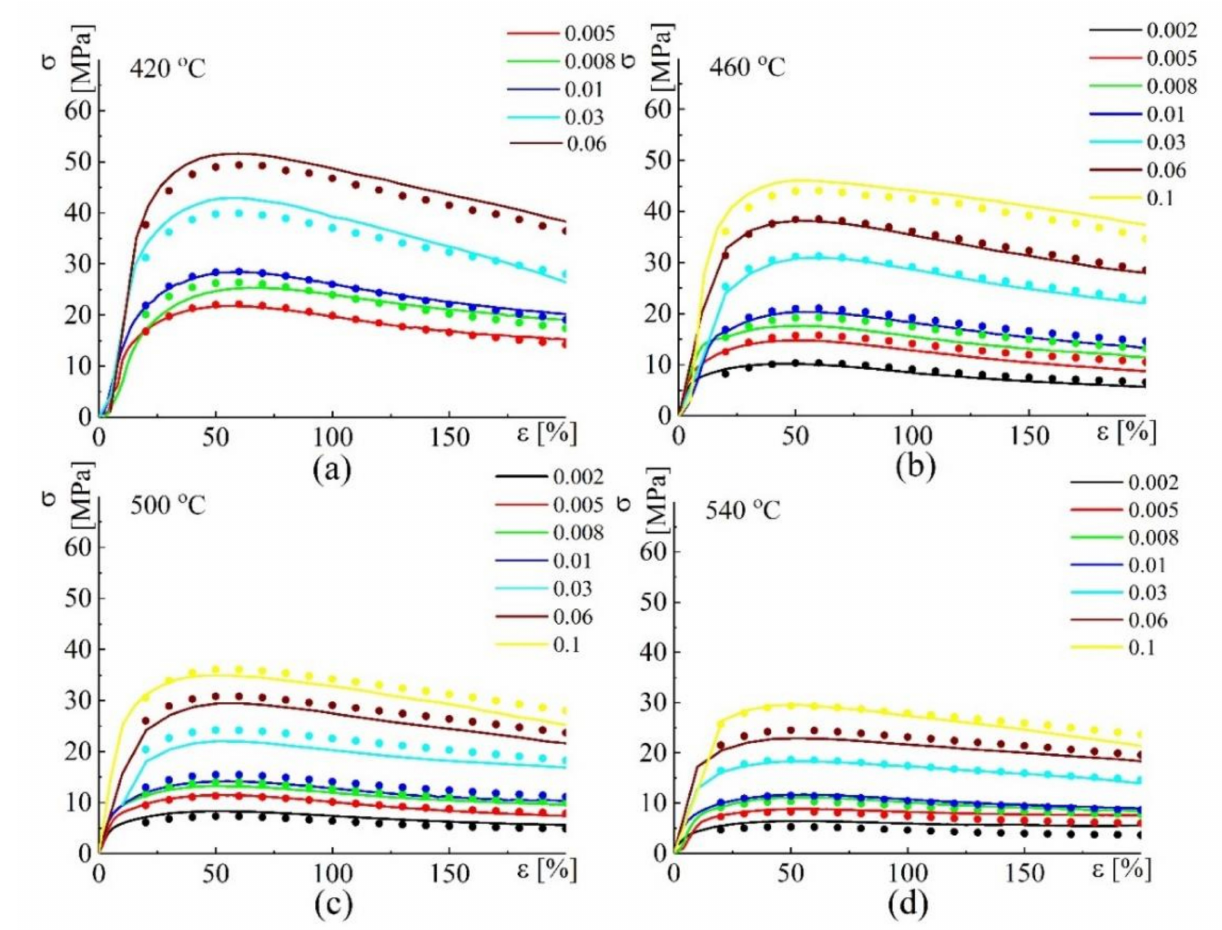
Figure 7. Experimental and predicted stress vs. strain via the ACE model at different strain rates and temperatures of ( a ) 420 ◦ C, ( b ) 460 ◦ C, ( c ) 500 ◦ C, and ( d ) 540 ◦